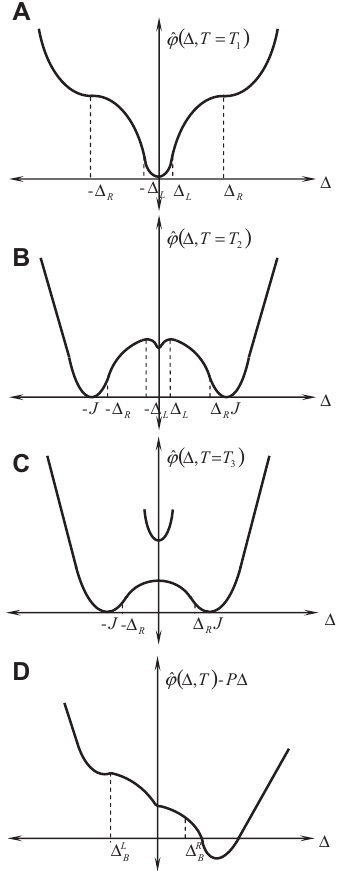
Figure 14 Helmholtz free energy for a lattice layer at three different temperatures: (A) high, (B) intermediate and (C) low. (D) represents the gibbs free energy of a load at an intermediate temperature.